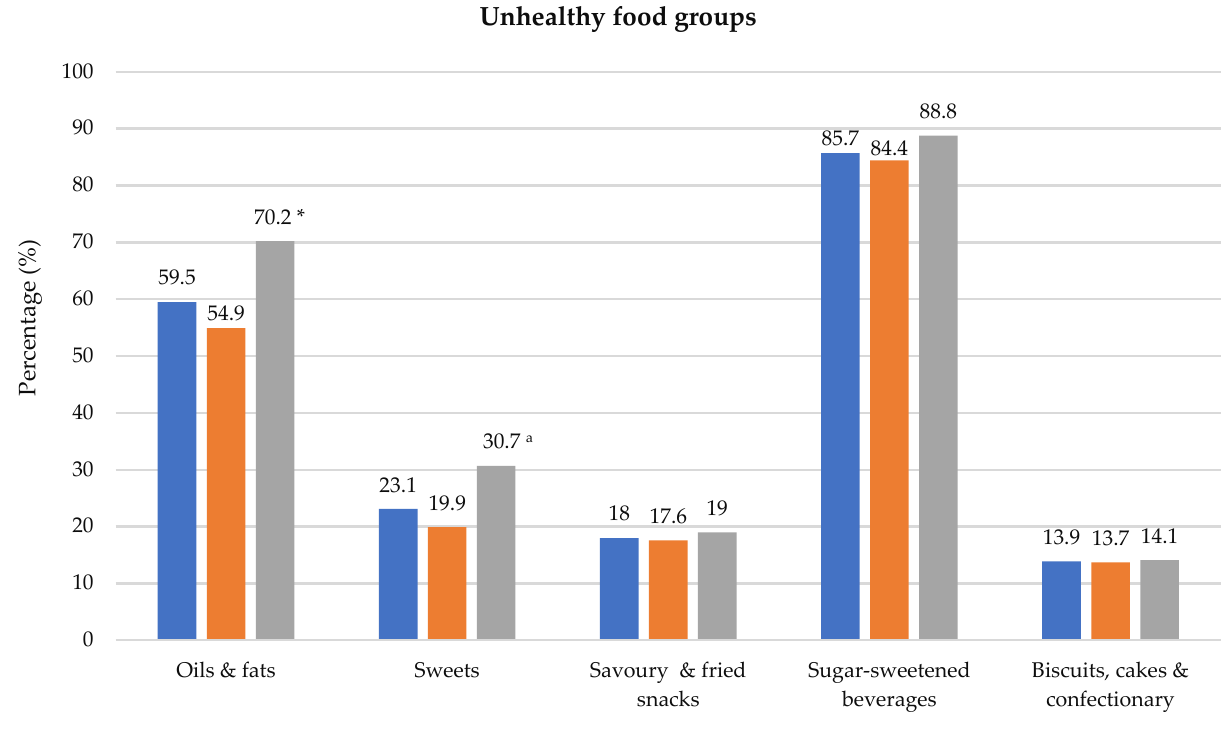
Figure 2. Percentage of participants who consumed unhealthy food groups the previous day dietary diversity (DD) score categories. * Significant difference between DD score categories at p < 0.001 level, Chi-square test. a Significant difference between DD score categories at p < 0.05 level, Chi-square test. Sugar-sweetened beverages include tea/coffee with sugar, cool drink, fruit juice, flavoured water and energy drink . Table 2. Food groups consumed by more than 50% of participants per dietary diversity score quin- tile for the total study sample.